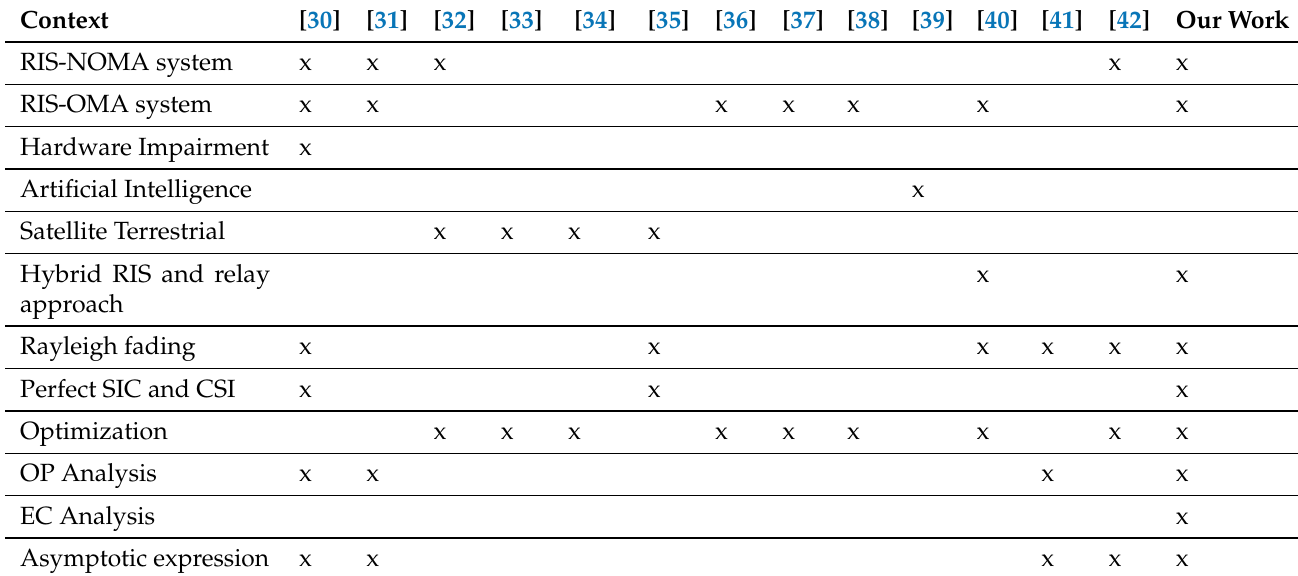
Table 1. Comparison between our work and existing